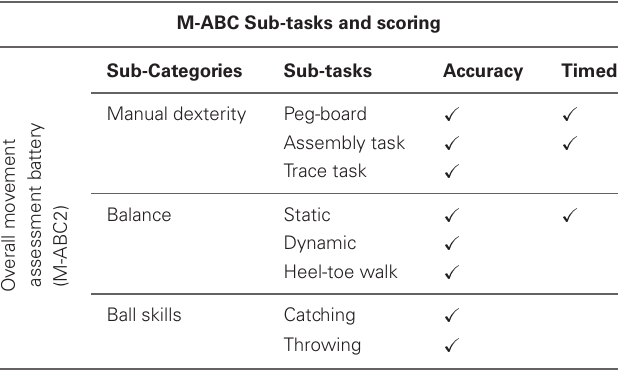
Table 1 | Table outlining the construction of the movement assessment battery for children 2 (Henderson and Sugden,